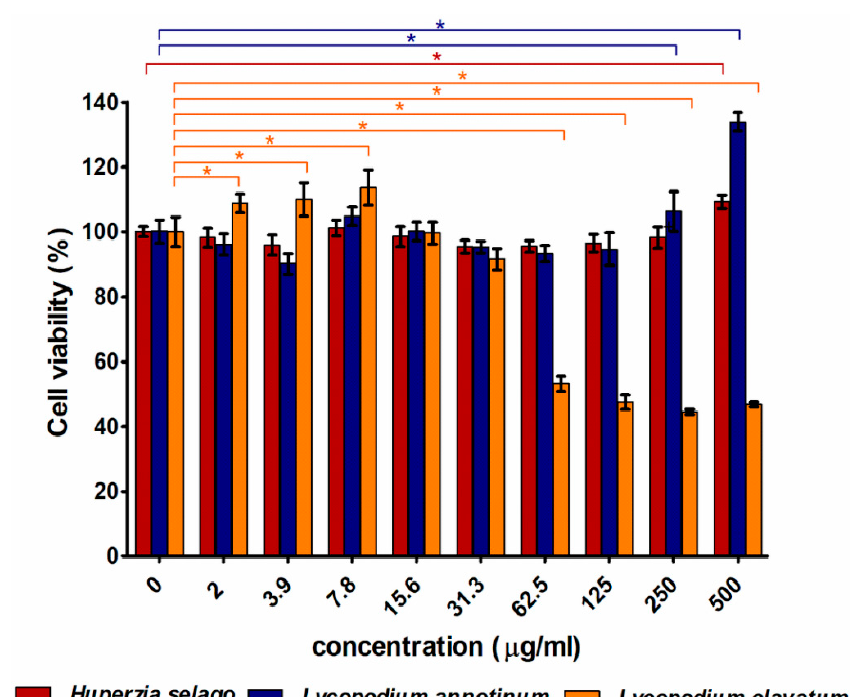
Figure 5. Cytotoxicity of tested extracts against human skin fibroblasts (BJ cell line) determined using MTT assay after 24 h exposure time; * p < 0.05—statistically different results compared to the control cells (concentration = 0 μ g/mL).